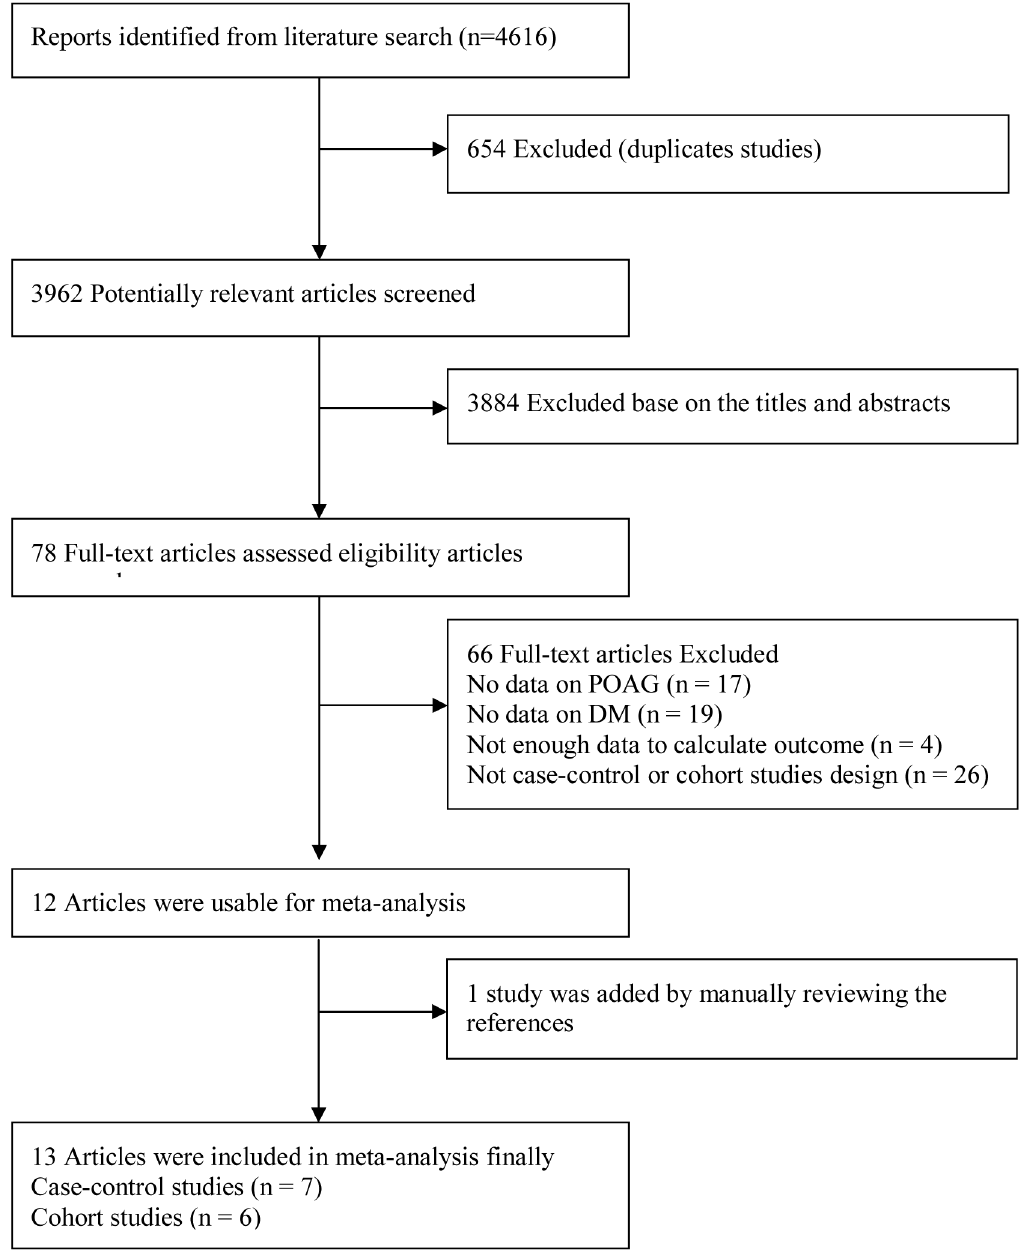
Figure 1. Flow diagram outlining the selection process for the inclusion of the studies in the systematic review and meta-analysis. POAG=primary open-angle glaucoma; DM=diabetes mellitus.